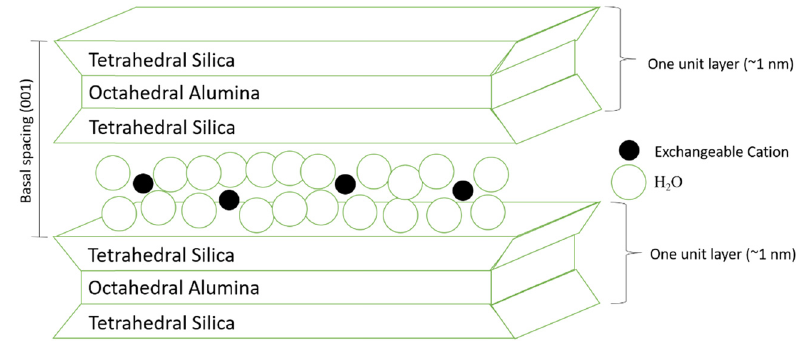
Figure 3: Montmorillonite smectite crystal structure.